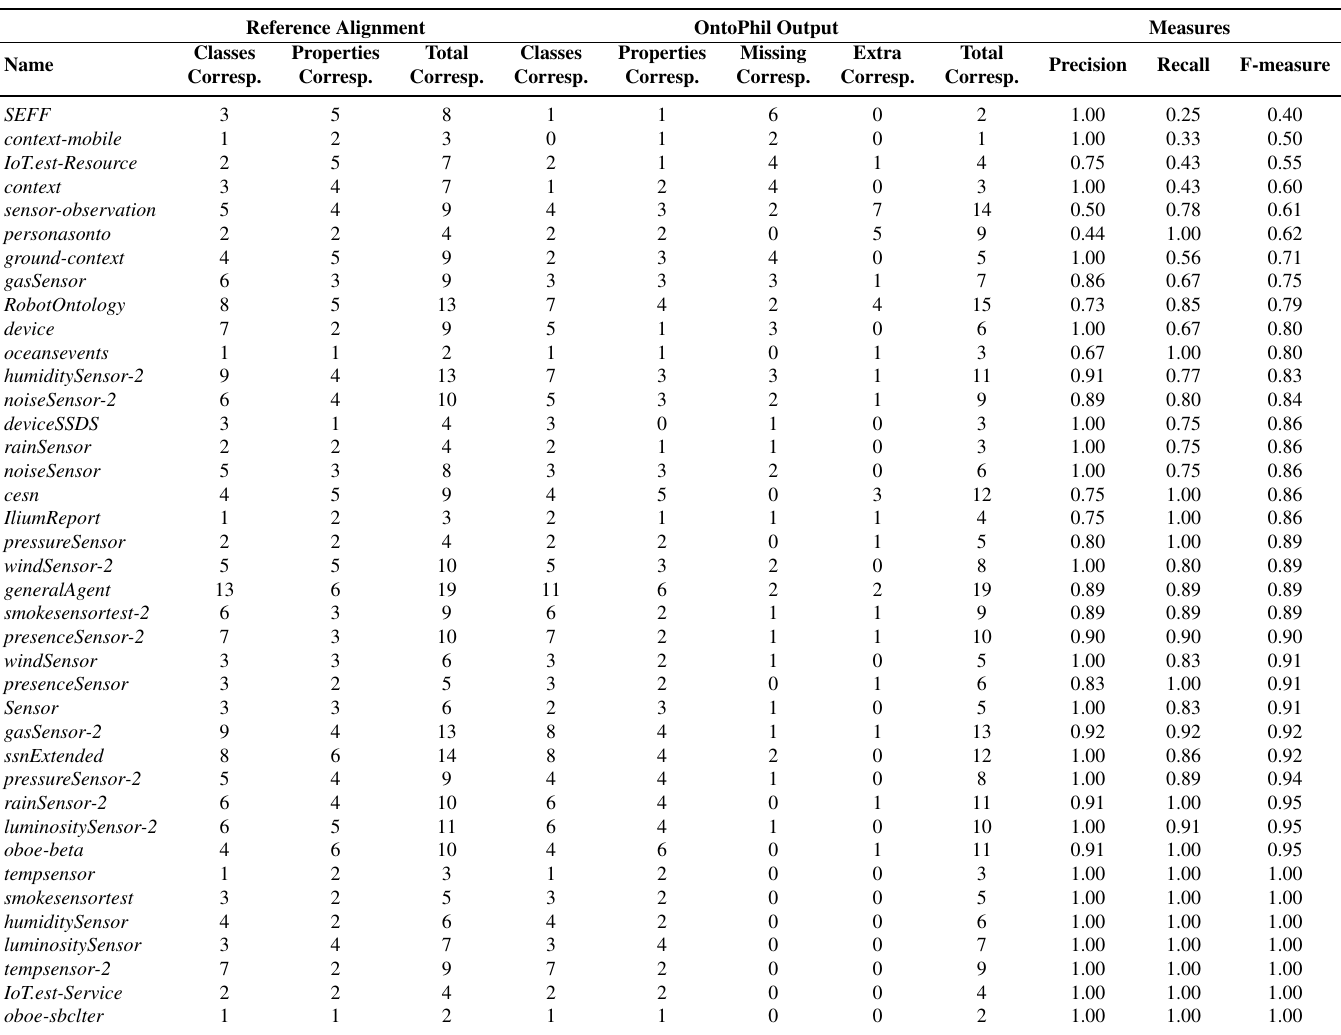
Table 8. Results obtained using the reference